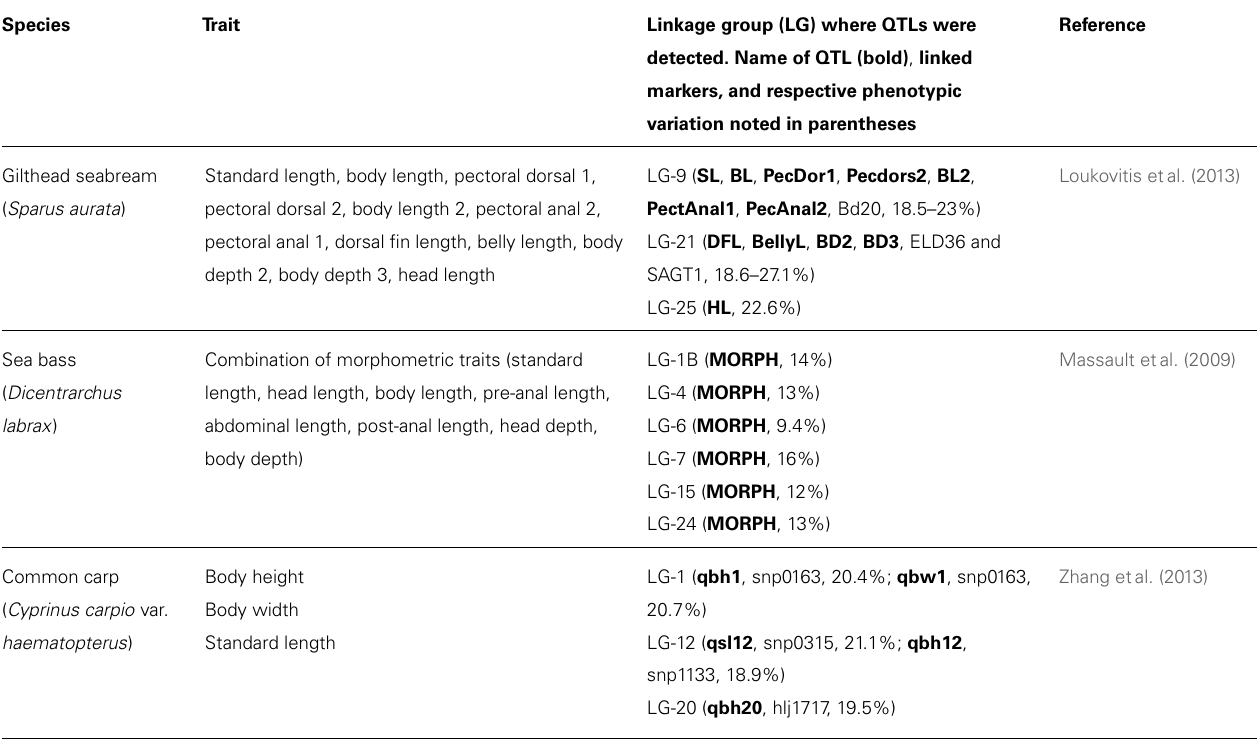
Table 2 | Examples of QTLs for body shape-related traits mapped on different commercial fish genomes. Species Trait Linkage group (LG) where QTLs were